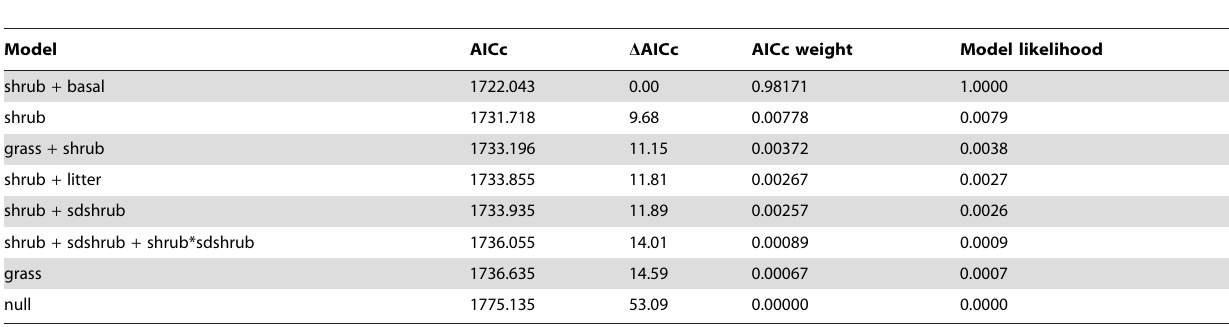
Table 6. Results from age-structured robust design models using Huggin’s estimator to derive population size and constrained by vegetation